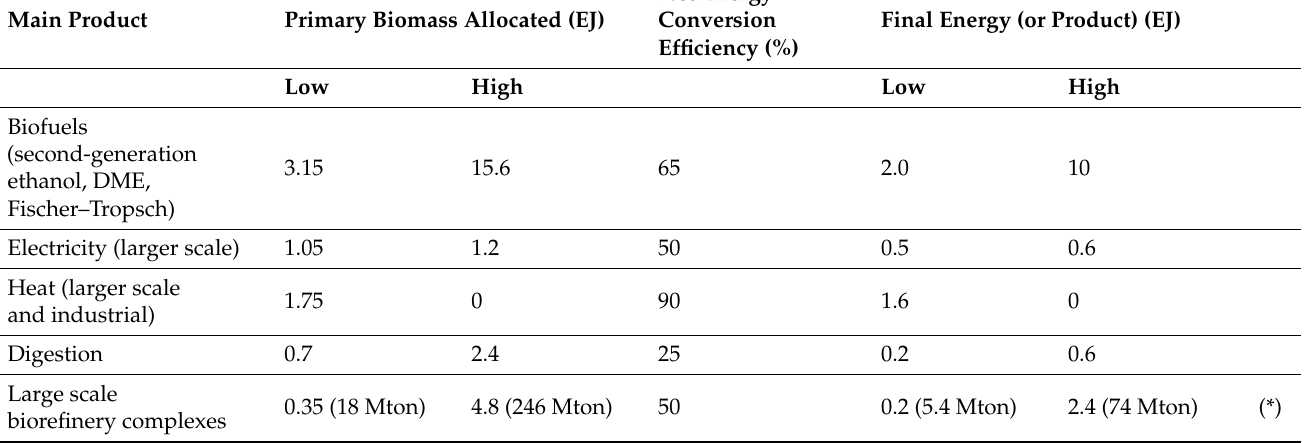
Table 3. Ranges for biomass deployment for different main uses in Europe in 2050, as derived from scenario analysis with a state-of-the-art energy optimization model [27,28]. The high biomass potential will result in a high impact of biomass use in GHG mitigation and the low biomass potential in low impact.